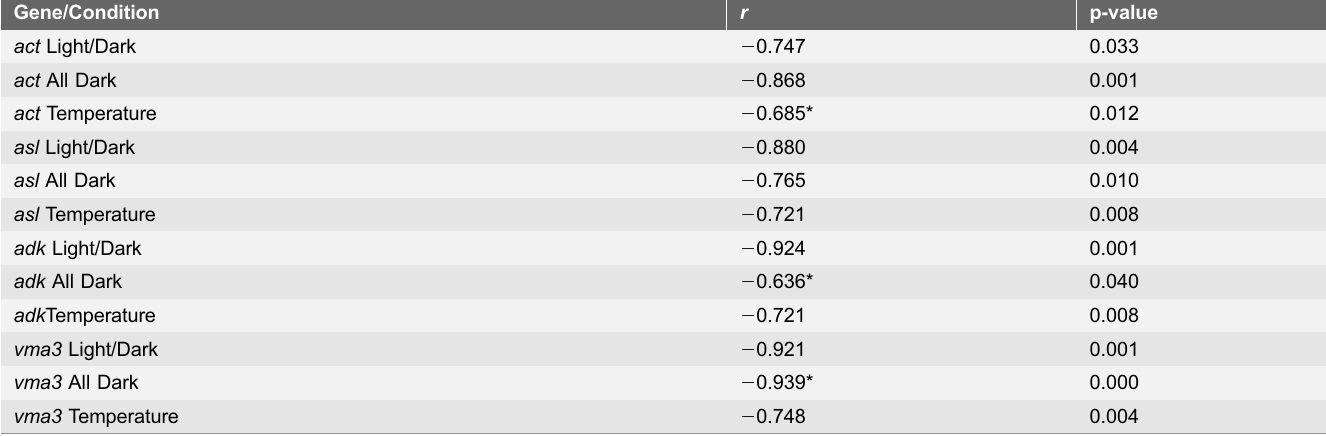
Table 6. Pearson Product Correlation values obtained for ratio and CT of act , adk , asl , and vma3 under each